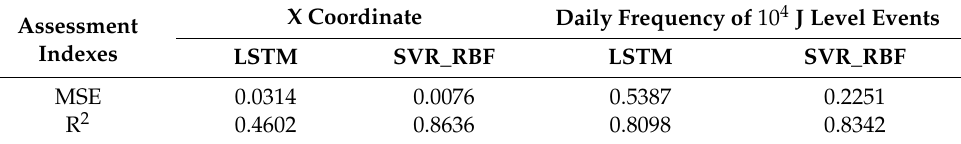
Table 7. Comparison of model performance.